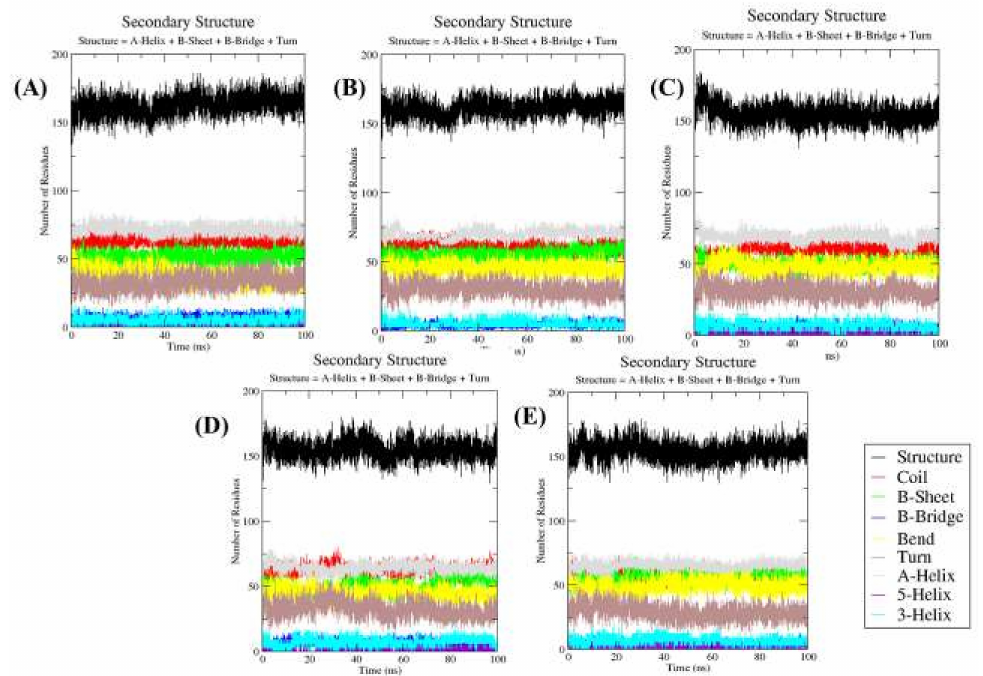
Figure 8. Secondary structure plot. The secondary structure analysis indicating the structural elements present in ( A ) Mrlip1, ( B ) Mrlip1-RHC80267, ( C ) Mrlip1-ZINC85530919, ( D ) Mrlip1-ZINC95914464, and ( E ) Mrlip1-ZINC85530320 during the 100 ns MD